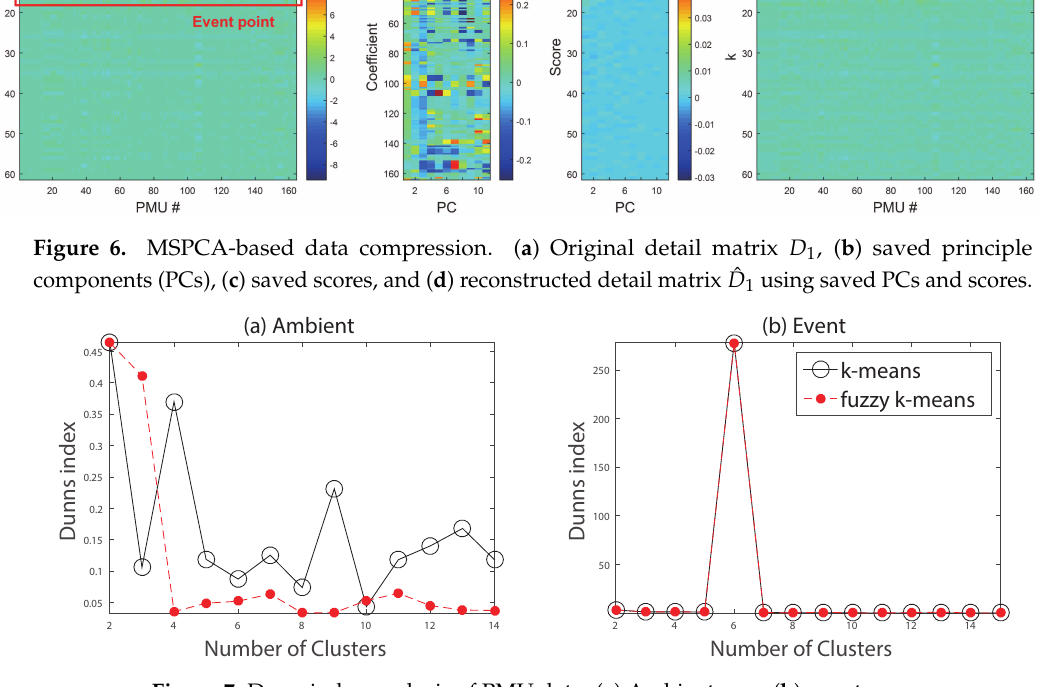
Figure 7. Dunn index analysis of PMU data. ( a ) Ambient case, ( b ) event case.